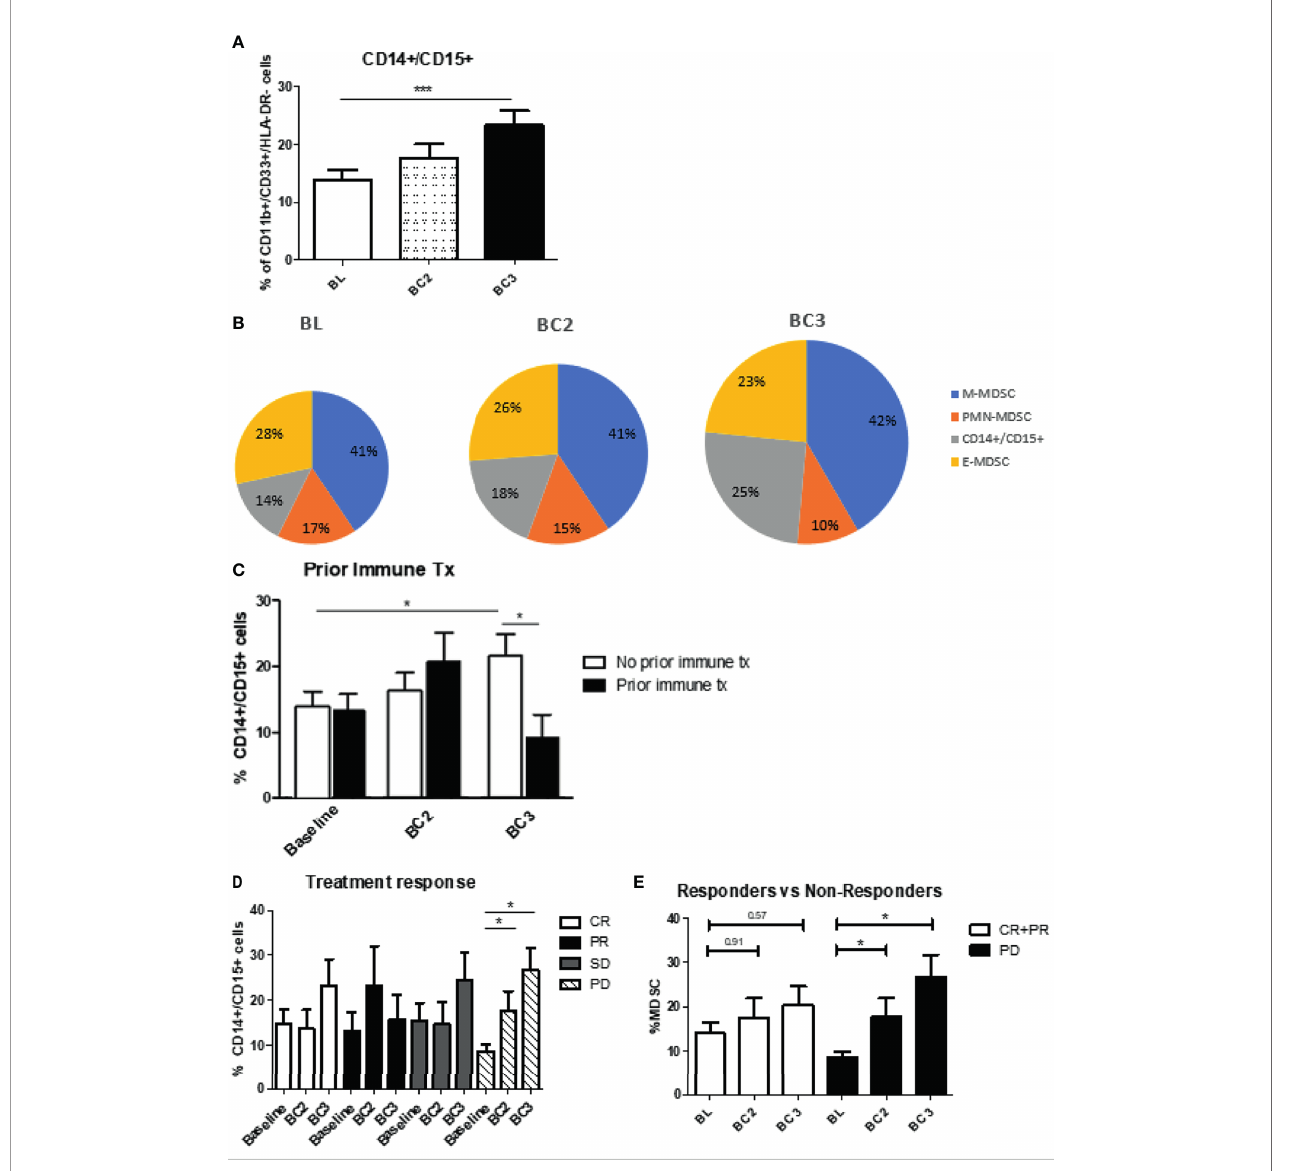
FIGURE 7 | Levels of CD14/CD15 double positive cells. (A) Patient PBMCs were evaluated for CD14/CD15 double positive cells and analyzed over the course of immune checkpoint blockade. (B) Changes to the proportions of the different MDSC subsets along with these double positive cells are shown over the course of immune checkpoint blockade, with size of pie chart corresponding to increasing MDSC percentage. Levels of the double positive cells were analyzed with regards to (C) prior immune therapy, (D) clinical response, (E) responders vs non-responders. Data are shown as mean ± SE, *p < 0.05, ***p <